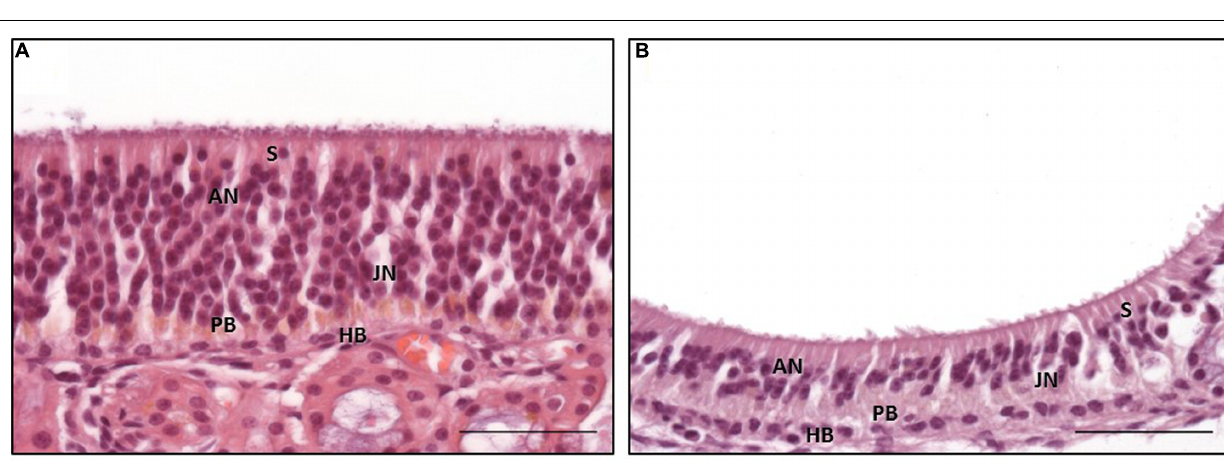
FIGURE 3 | Distinct subtypes of the olfactory epithelium; (A) OE type a with numerous adult olfactory neurons with euchromatic nuclei and distinct nucleoli in the middle third of the epithelium reaching toward the luminal surface, (B) OE type b with a reduced number of adult olfactory neurons forming a nucleus-free zone near the luminal surface; S: sustentacular cells, AN: adult neurons, JN: juvenile neurons, PB: proliferating basal cells, HB: horizontal basal cells; H&E staining; scale bar: 50 µ